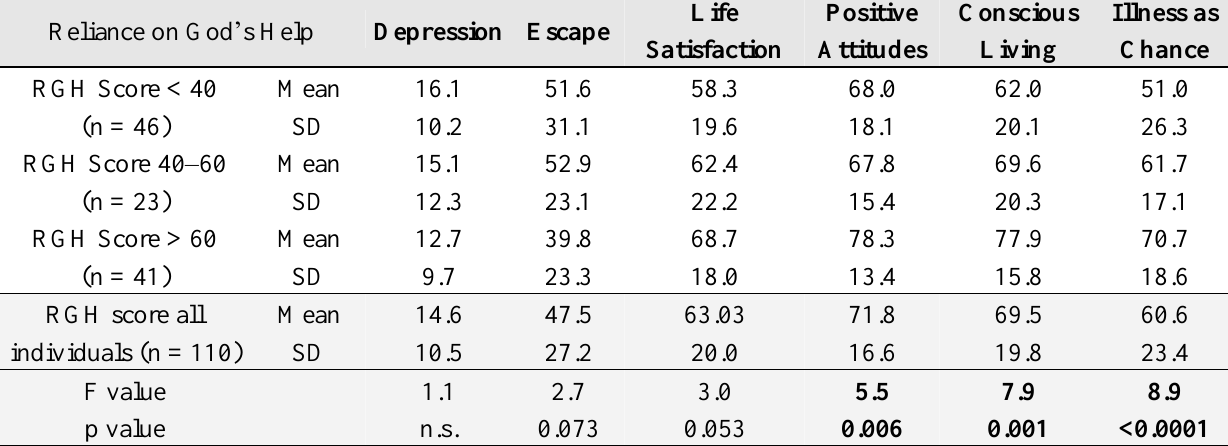
Table 3. Intensity of RGH and psychological variables /